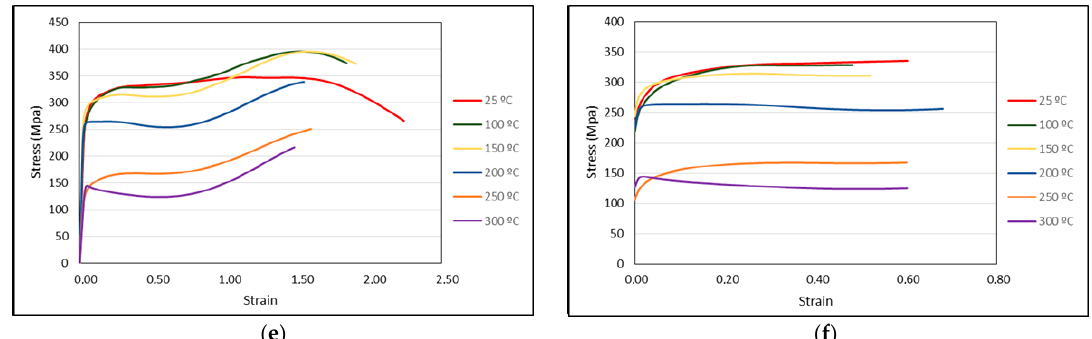
Figure 5. Complete flow rules experimentally obtained for AA5754 and their corresponding plastic zones selected for the development of the new flow rule: ( a ) complete flow curves for AA5754 at N0; ( b ) selected zone for AA5754 at N0; ( c ) complete flow curves for AA5754 at N2; ( d ) selected zone for AA5754 at N2; ( e ) complete flow curves for AA5754 at N2 + flash; ( f ) selected zone for AA5754 at N2 + flash.